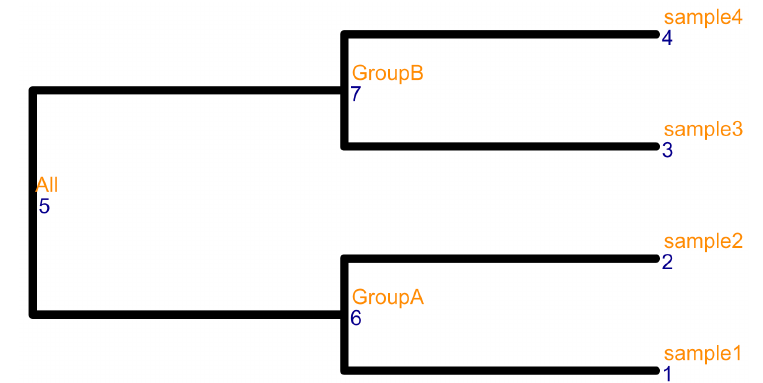
Figure 3. The structure of the column tree. The node labels and the node numbers are in orange and blue text,